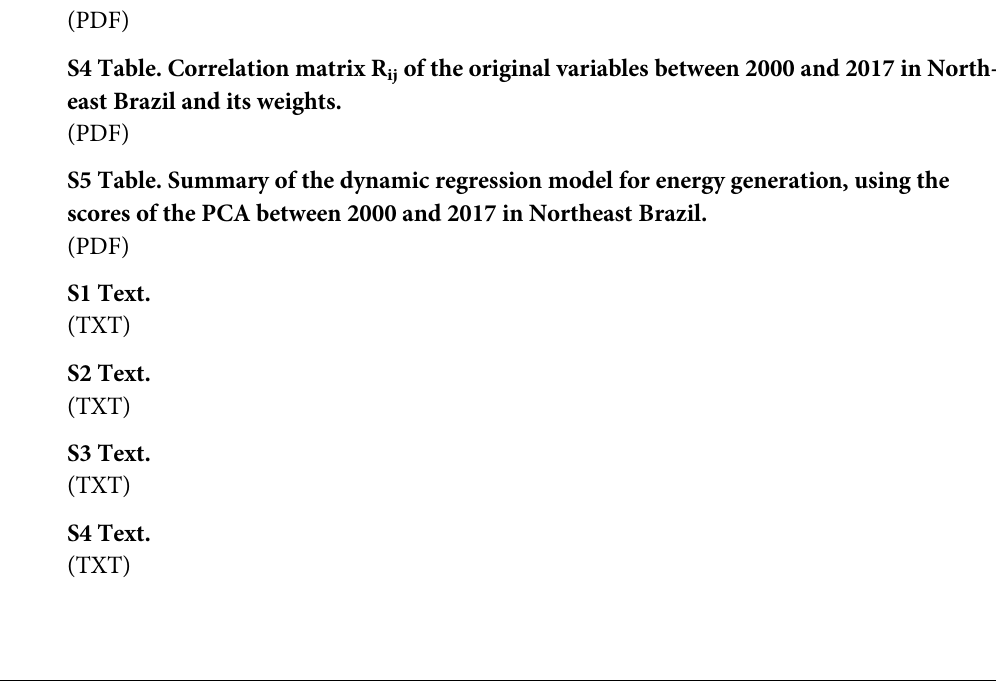
S5 Fig. Monthly distribution of (a) energy generation, (b) energy imports and (c) energy load in Northeast Brazil between 2000 and 2017. S6 Fig. Annual time series of the useful volume and streamflow of Sobradinho Reservoir in Northeast Brazil between 2000 and 2017. S7 Fig. Monthly seasonality of the variables a) precipitation, b) water streamflow and c) useful volume between 2000 and 2017 in Northeast Brazil. S8 Fig. Simulation of energy generation by the dynamic regression model, using climate variables from PCA (scores—PC1, PC2 and PC3) between 2000 and 2017 in Northeast Bra- zil. S9 Fig. Residual analysis of the simulations by the dynamic regression model of energy generation, using PCA between 2000 and 2017 in the Northeast Brazil. S1 Table. Weather stations of INMET. S2 Table. Descriptive statistic of rainfall in Northeast Brazil between 1964 and 2015 at lati- tudes 9˚ to 17˚ South and longitudes 42˚ to 47˚ West (2˚.5’ x 2˚.5’) with 5% significance level. All average values are in mm. S3 Table. Descriptive statistic of incremental streamflow (m 3 .s − 1 ) at gauge 168 of Sobra- dinho Dam between 1964 and 2017 in Northeast Brazil. Q � : Quarter. S4 Table. Correlation matrix R of the original variables between 2000 and 2017 in North- ij east Brazil and its weights. S5 Table. Summary of the dynamic regression model for energy generation, using the scores of the PCA between 2000 and 2017 in Northeast